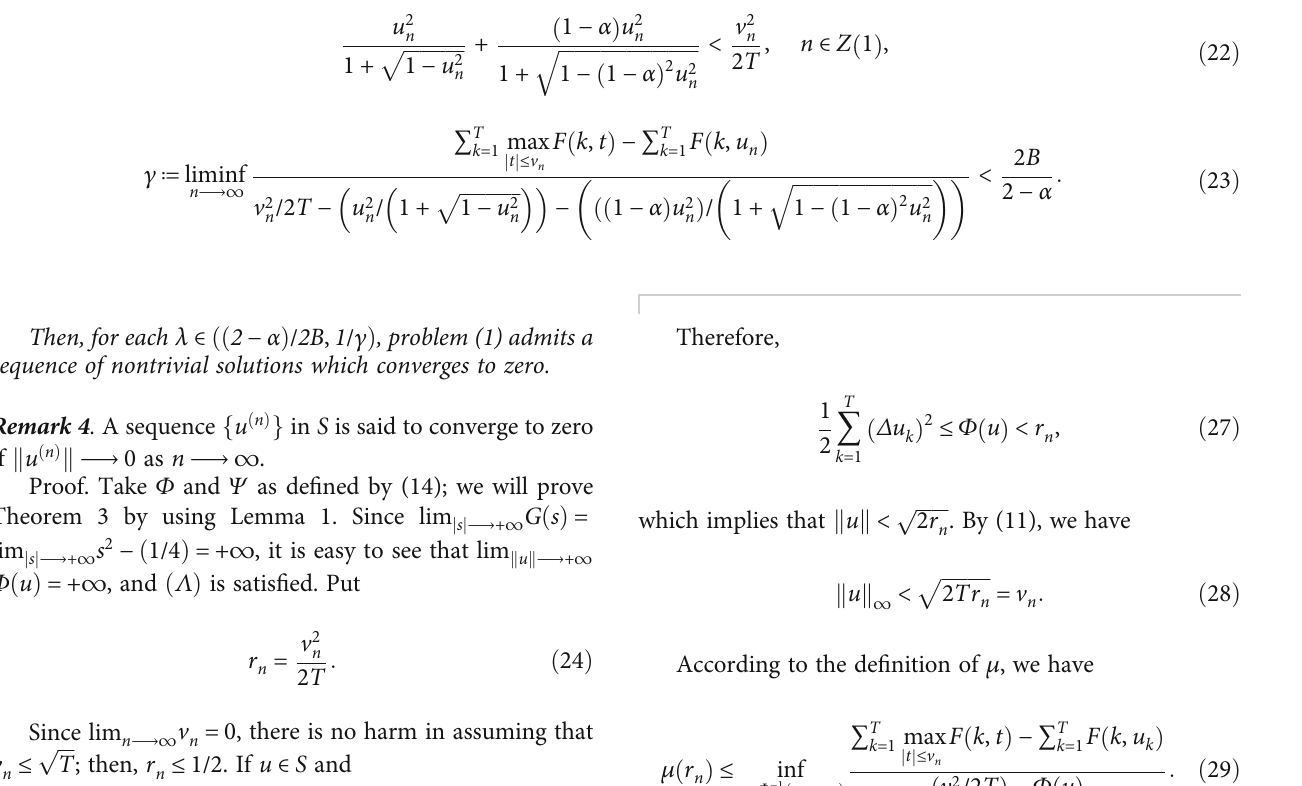
ffiffiffiffiffiffiffiffiffiffiffiffiffiffiffiffiffiffiffiffiffiffiffiffiffiffiffi